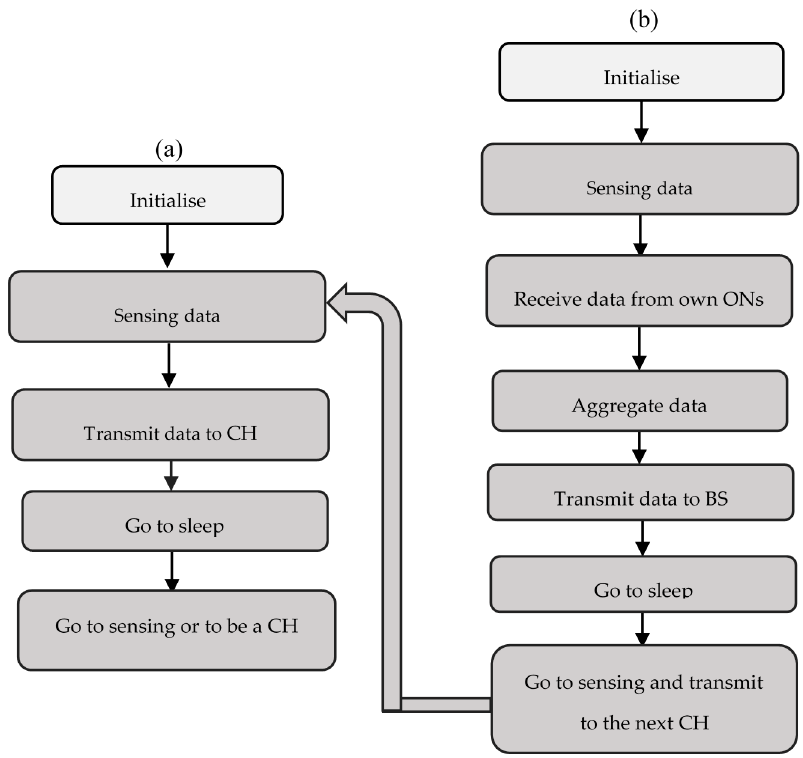
Figure 4. ( a ) CM behavior during the steady phase ( b ) CH behavior during the steady